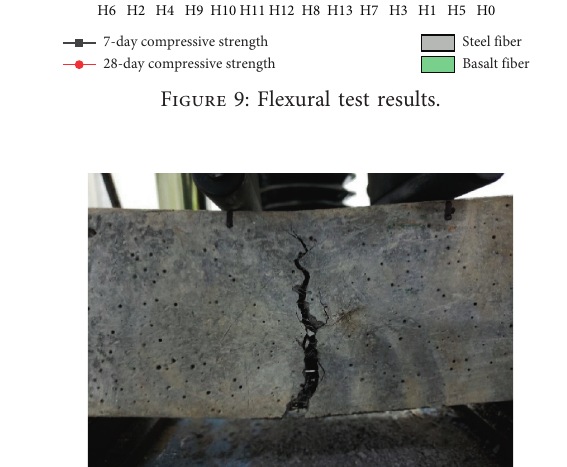
Figure 10: Failure condition of flexural